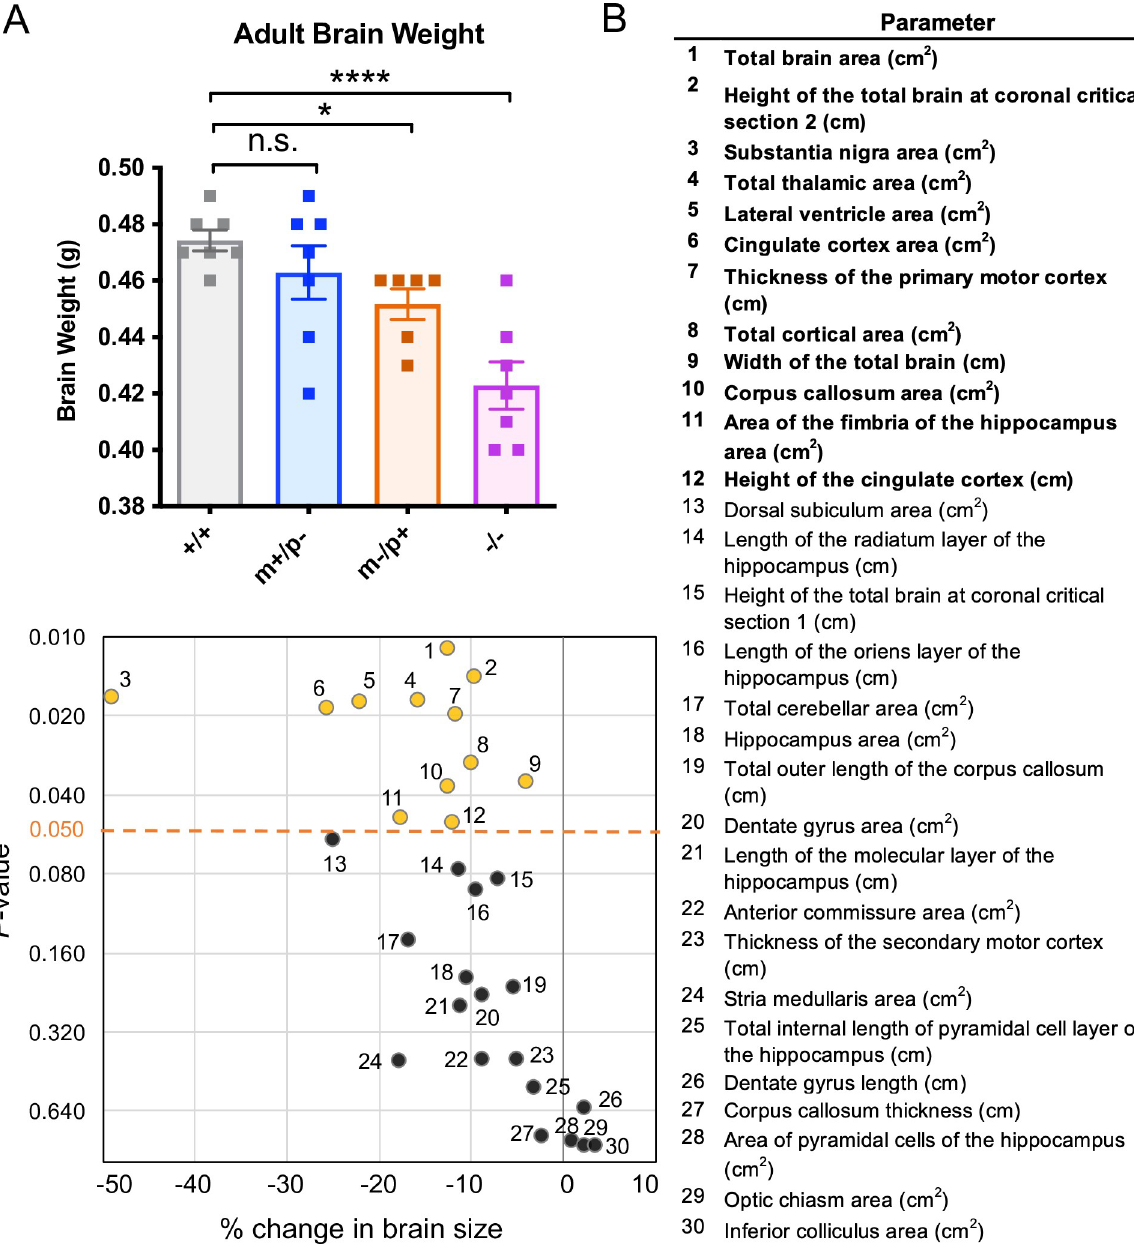
Trappc9 -/- mice (n = 13) moved 22% less than their wild-type littermates (n = 22) ( p < 0.01, one-way ANOVA with Tukey’s post hoc test, Fig 5A, S10A Fig, S6 Data). Similarly, in a